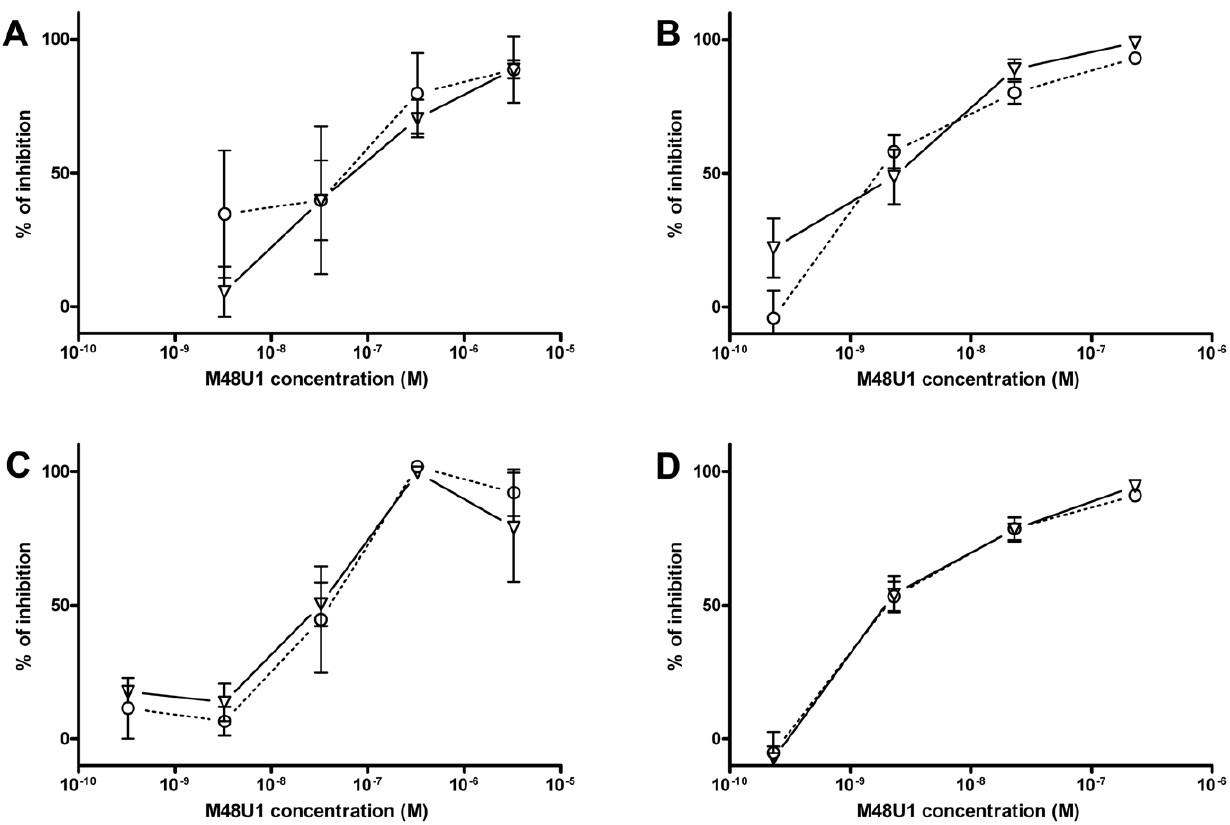
Figure 1. Inhibition of HIV-1 Ba-L infection by M48U1 in genital tissue explant models. Inhibition of HIV-1 Ba-L infection of cervical ( A ) and colorectal ( B ) tissue explants pre-treated with M48U1. ( C ) Inhibition of HIV-1 Ba-L trans-infection of PM-1 T cells co-cultured with cells migrating out of cervical tissue explants treated with M48U1. ( D ) Inhibition of HIV-1 Ba-L infection of colorectal tissue explants treated with M48U1 coming from dilution of the formulation at 0.3% in the gel used for in vivo challenge, comprising 1.5% hydroxyethylcellulose (HEC), 0.1% sorbic acid and 2.5% glycerol kept at 4 u C during more than one year. Viral replication was assessed by measuring p24 production in supernatants at days 10 (circle, dotted line) and 15 (triangle, solid line). The percentage of inhibition was normalized relative to the p24 values obtained for explants not exposed to HIV-1 Ba- L (0% infectivity) and for explants exposed to HIV-1 Ba-L in the absence of M48U1 (100% infectivity). Data points correspond to mean values and error bars represent the standard error of the mean (SEM) from three independent experiments performed in